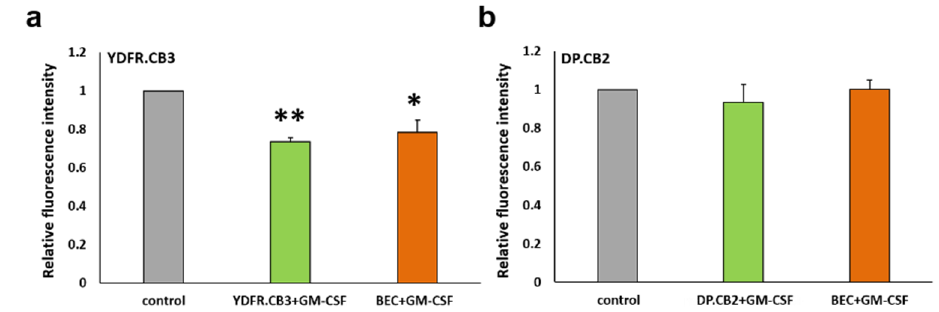
Figure 3. GM-CSF interferes with the interaction of certain metastatic melanoma cells with brain endothelial cells (BEC). ( a , b ) mCherry-expressing melanoma cells YDFR.CB3 ( a ) or DP.CB2 ( b ) were stimulated with 10 ng / mL rhGM-CSF for 24 h before seeded on top of BEC monolayer and incubated for 30 min, to allow adhesion to occur. Alternatively, unstimulated melanoma cells were seeded on rhGM-CSF-stimulated BEC. Adhesion assay of unstimulated melanoma and BEC was performed as control. The fluorescence signal of labeled cells was measured before and after removal of non-adherent cells. The bars represent the relative florescence intensity normalized to control. Each experiment consisted of 6 repeats for each treatment. The graph represents an average of three independent experiments ± SD. * p < 0.05, ** p < 0.01.